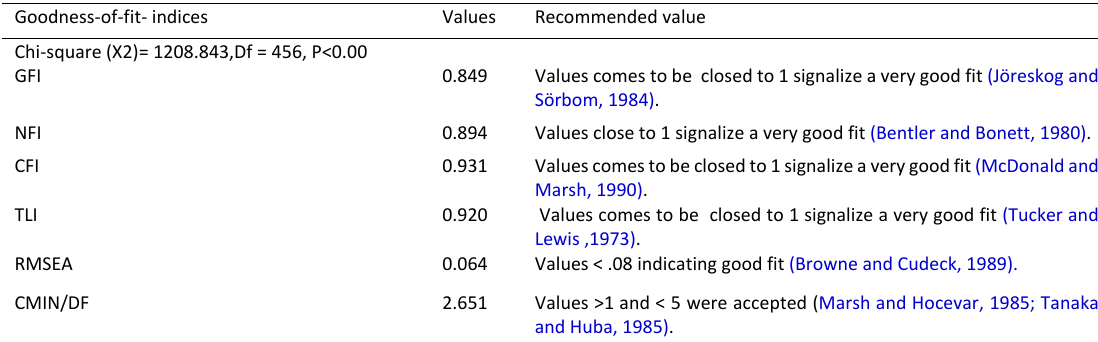
Fig. 2: Overall Confirmatory Factor Analysis Model for Research construct Table 2: fix model of Research construct